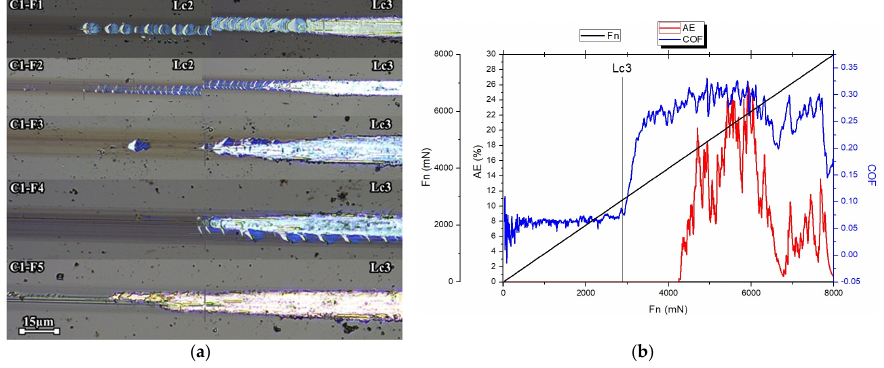
Figure 4. Areas of critical load ( a ), and the variation of friction coefficient and acoustic emissions as functions of the normal load ( b ). functions of the normal load ( b ). Table 3. Mean values of the critical loads and computed friction coefficient. Table 3. Mean values of the critical loads and computed friction